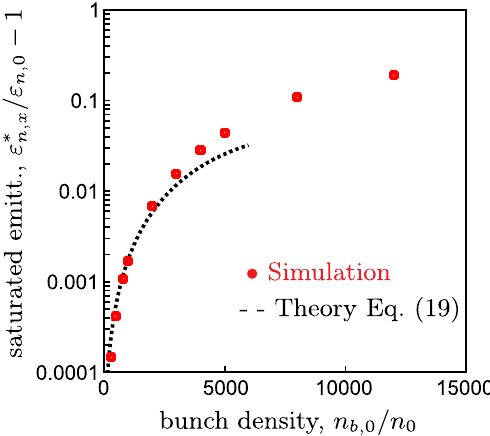
FIG. 3. Emittance growth at saturation for a Gaussian bunch initially matched in the unperturbed wakefield as function of the bunch peak density. Red dots are the simulation results, the black dashed line is the theoretical prediction Eq. (19). All the other bunch and plasma parameters are the same as in Fig.